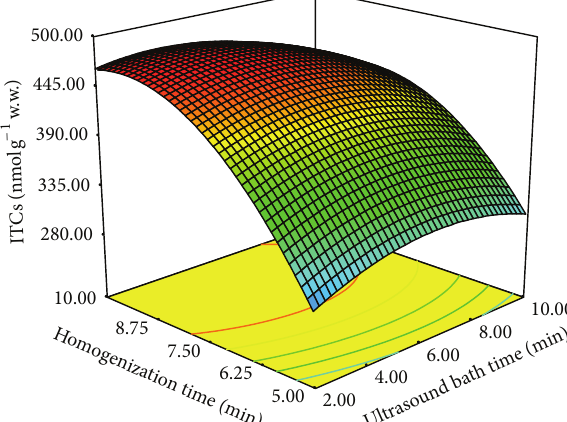
Figure 3: Effect of homogenization and ultrasound bath times on total ITCs extraction from broccoli samples.